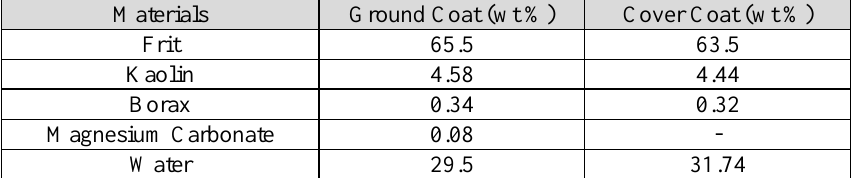
Table 2: Glass slurry for ground coat and cover coat [1].